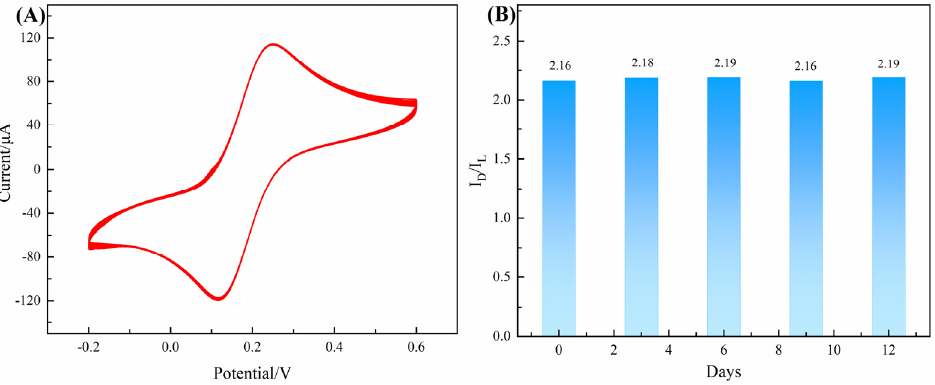
Figure 9. ( A ) CV of PAA-MWCNTs-Ag-SCS/GCE over 100 consecutive cycles. ( B ) Enantiomeric peak currents ratio for recognition of 5 mM L-Pen or D-Pen with different PAA-MWCNTs-Ag-SCS/GCEs prepared under identical conditions.